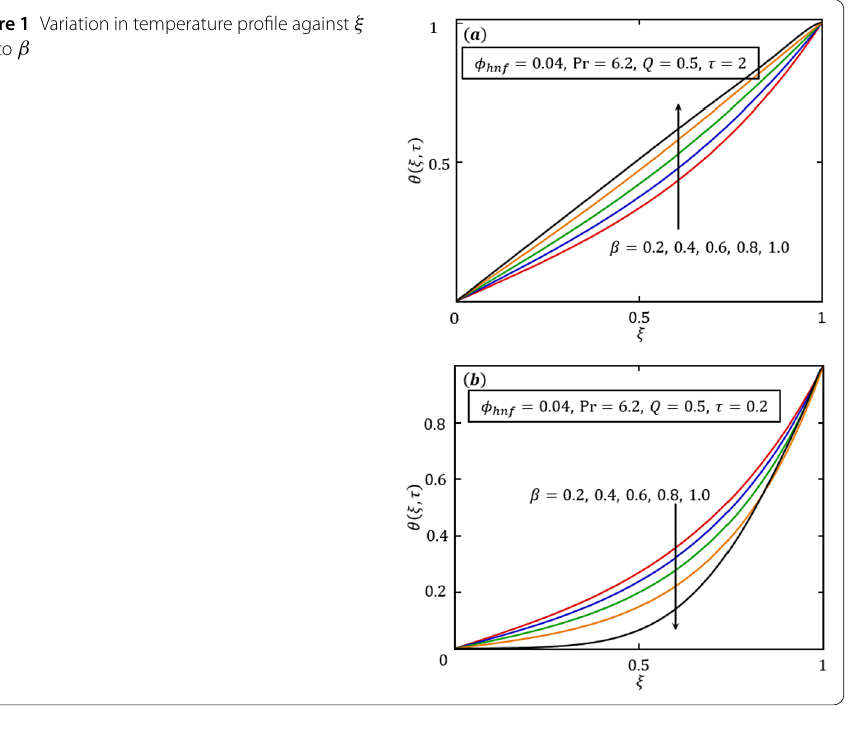
Figure 2 Variation in velocity profile against ξ due to α and